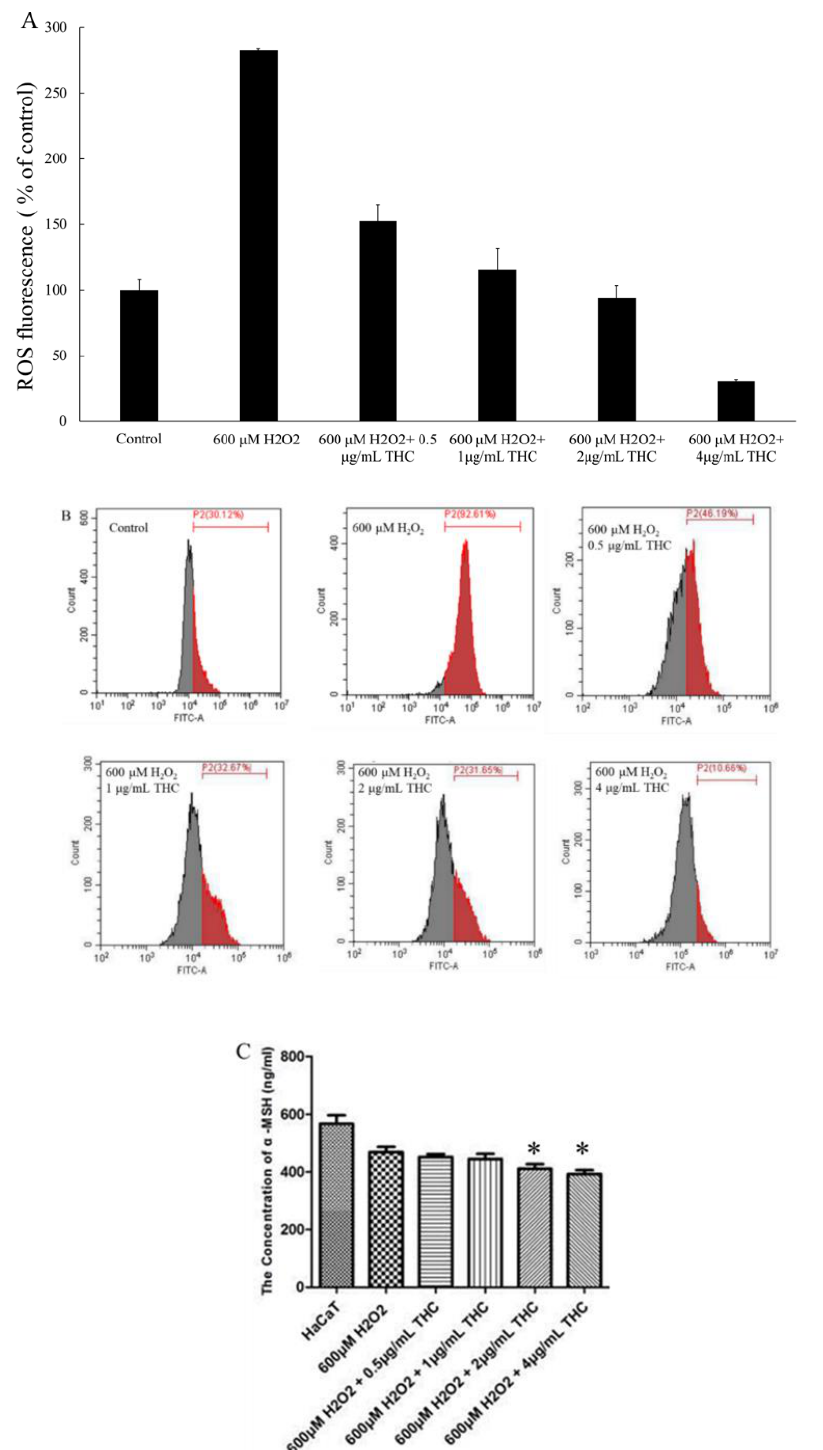
Figure 3. Protective role of THC on the H 2 O 2 induced ROS levels in HaCaT. ( A ) The summary of ROS levels in HaCaT cells ( B ) Intracellular ROS levels of HaCaT were assessed by flow cytometry. ( C ) α -MSH levels were found in the supernatant in HaCaT, after the cells were pretreated without or with the selected concentrations of THC (0.5, 1, 2, and 4 µg /mL) for 12 h prior to the addition of H 2 O 2 . Results are expressed as mean SD ( n = 3). * p < 0.05 compared to the cells treated with 600 µM H 2 O 2 only.